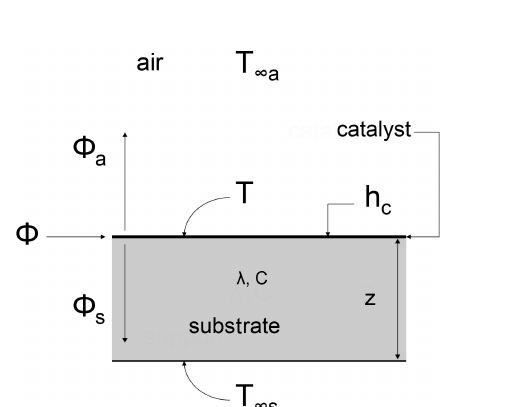
Figure 1. TEM micrographs of catalyst A: (a) and (b) ; catalyst C: (c) and (d) .